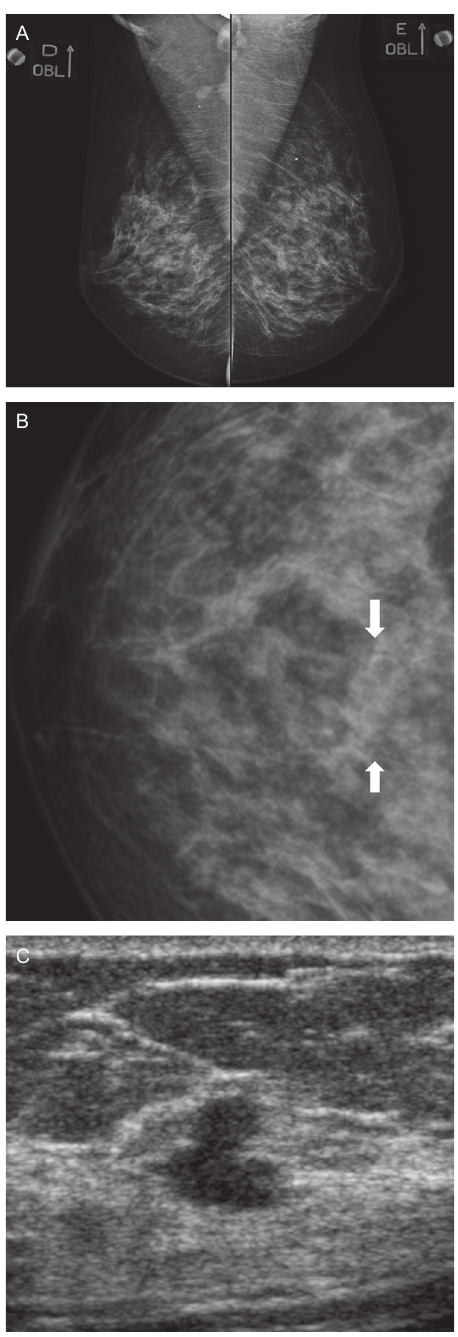
Figure 2 A - B - Oblique views of both breasts and a magnification of the central region of the right breast. A subtle round asymmetry is seen in the right breast (arrow in B ), which was found to be a cyst (not shown). C. Additionally , US demonstrated an irregular mass, which was revealed to be Invasive Lobular Carcinoma